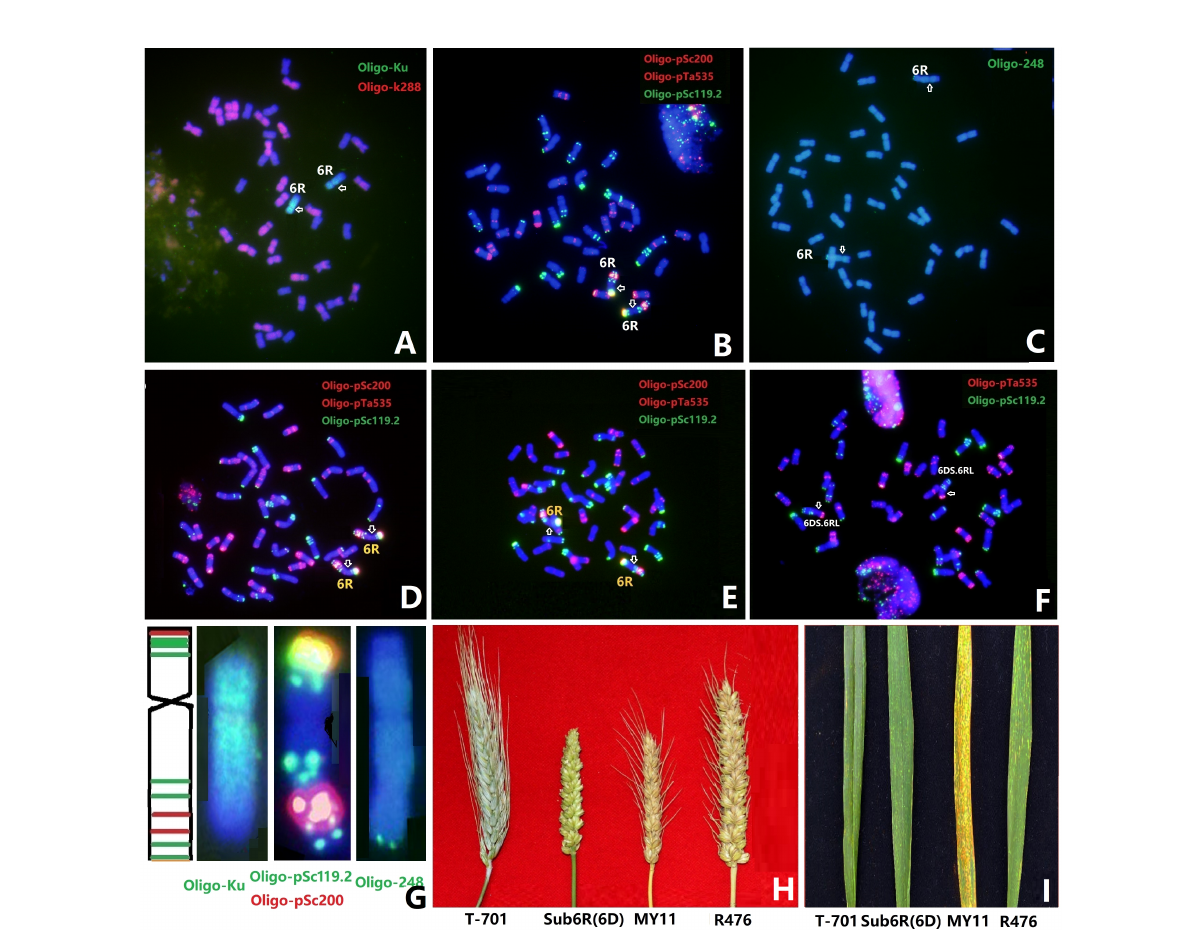
FIGURE 1 ND-FISH karyotyping of chromosome 6R in different wheat backgrounds. FISH of Sub6R(6D) line was performed using rye-speci fi c oligo probe Oligo-Ku (A) , Oligo-pSc119.2+ Oligo-pSc535 + Olio-pSc200 (B) , and Oligo-238 (C) . Lines R323 in CM42 (D) , R476 in MY11 (E) , and R27 with T6DS.6RL in MY11 (F) were revealed by ND-FISH using probes Oligo-pSc119.2, Oligo-pTa535, and Olio-pSc200. The karyotype of 6R is shown using multiple probes (G) , the spike morphology (H) and stripe rust reaction (I) of the above wheat-6R lines and the parents are presented. Arrows pointed the positions of centromeres of